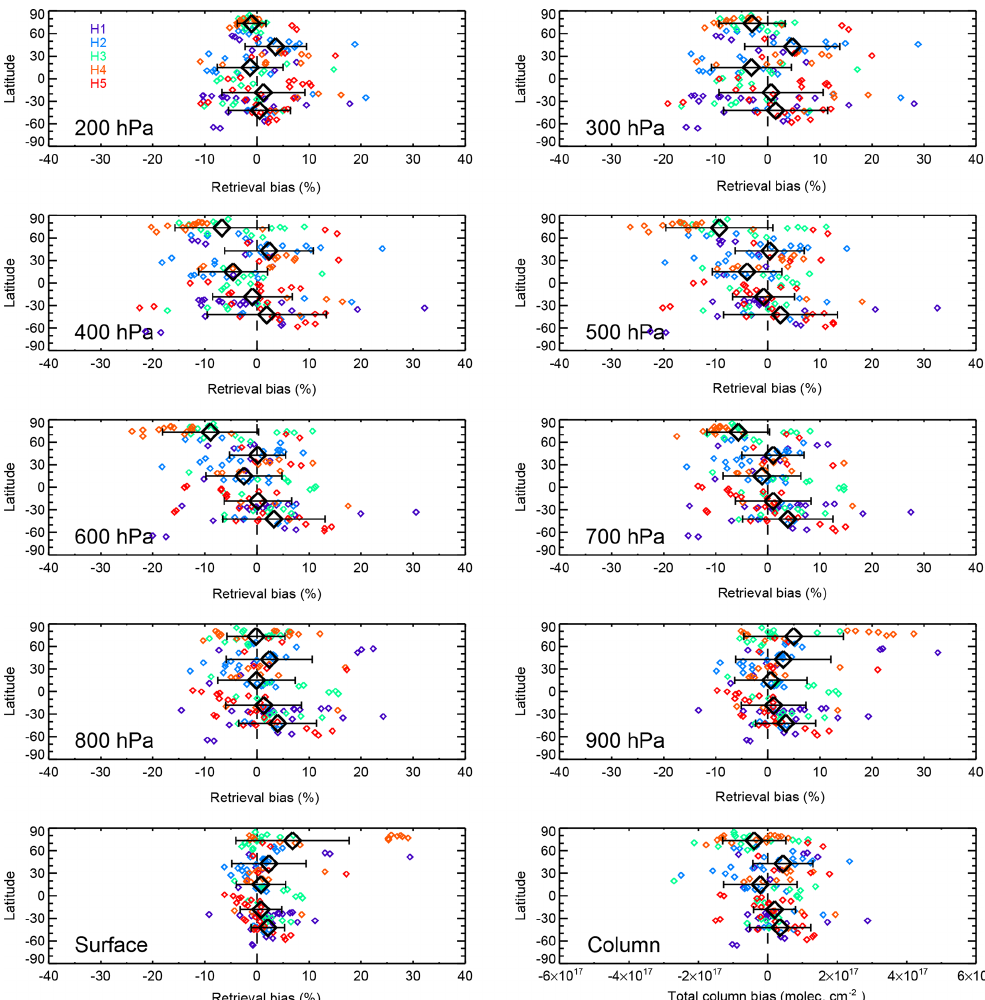
Figure 6. Latitude dependence of V8 TIR-only biases (expressed in percent) based on the HIPPO CO profiles. See caption to Fig.